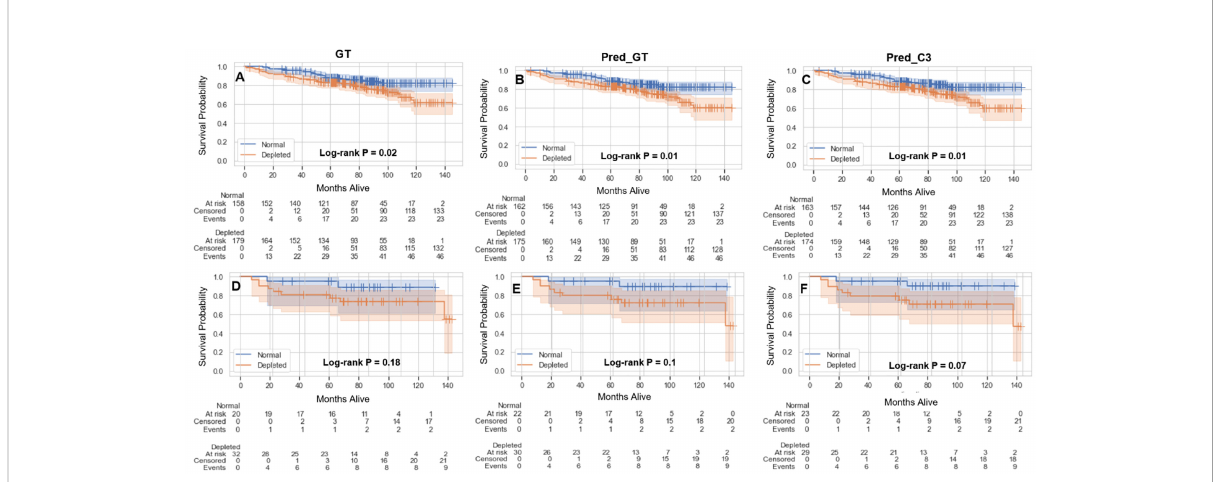
FIGURE 5 Kaplan-Meier plots showingoverall survival probabilities(test and validationset combined, 390 patients) as a functionof time in daysfor estimated skeletal muscle (SM) index (normal vs depleted) in male (A-C) andfemale (D-F) patients usingthe ground-truth SMsegmentation(GT) (A, D) , auto- segmented SM usingthe ground-truthslice location(Pred_GT) (B, E) , and auto-segmented SMusing the auto-selected slicelocation (Pred_C3) (C, F)